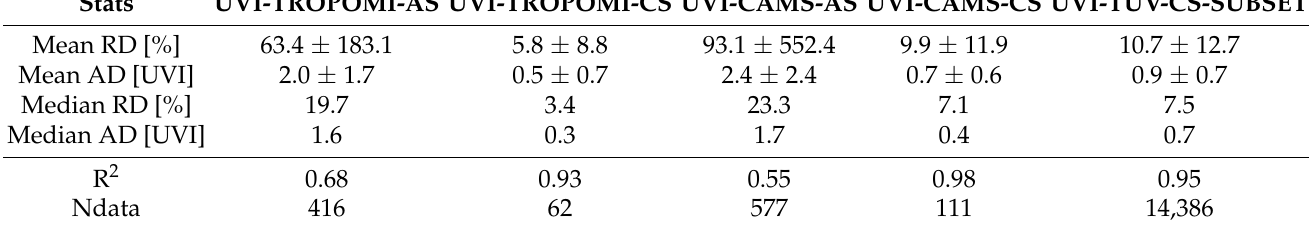
1 Standard deviation is also ±